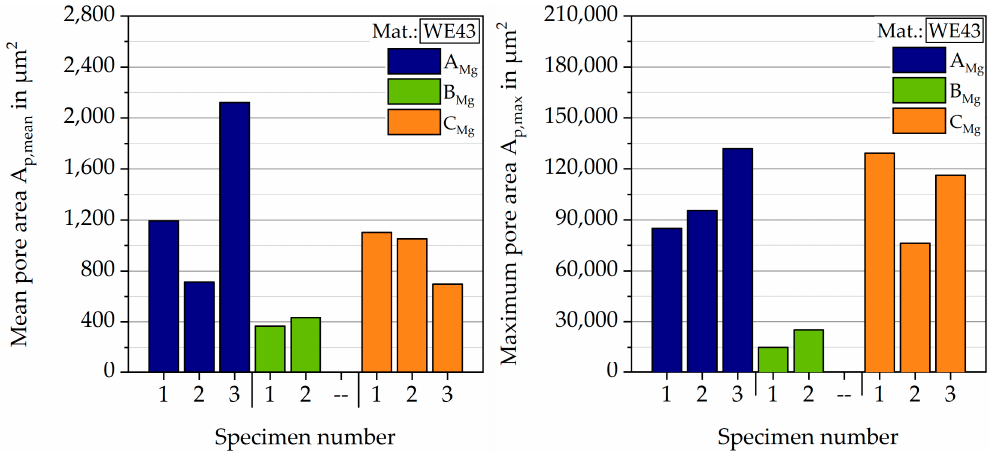
Figure 8. Mean and maximum pore area of magnesium specimens.